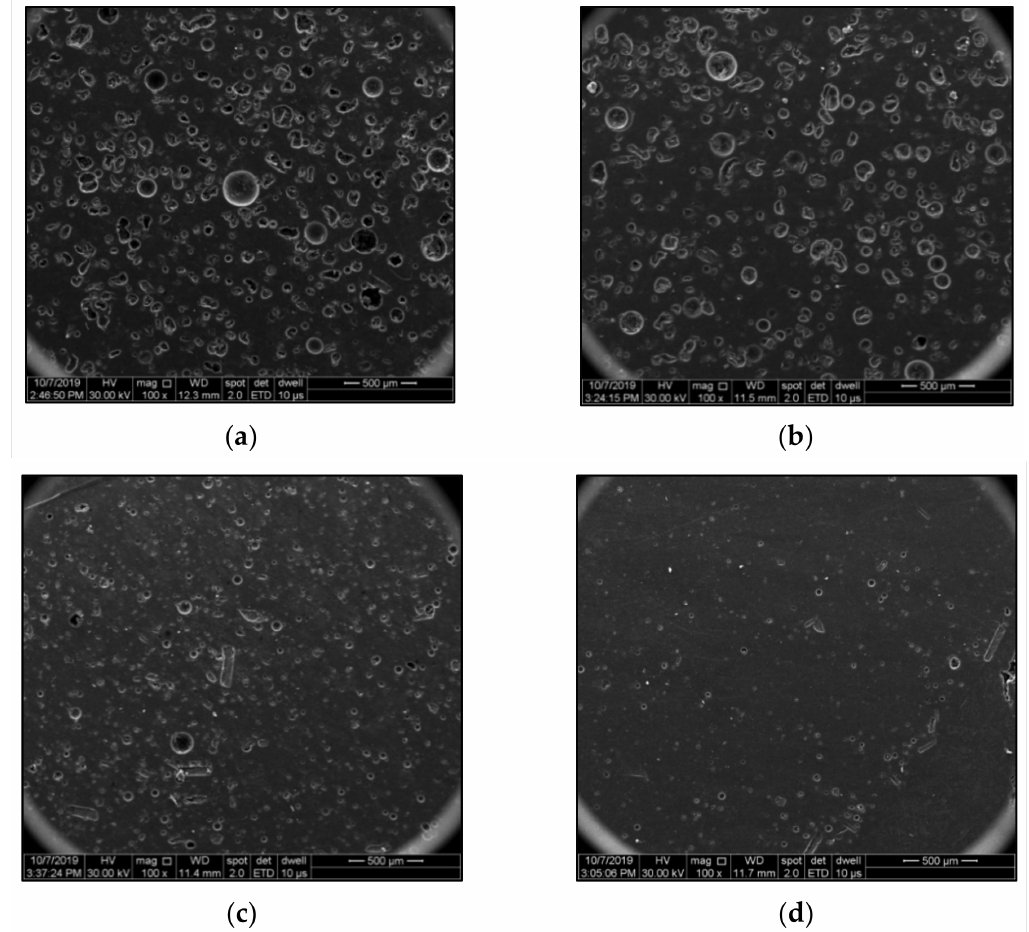
Figure 5. SEM images illustrating the dispersion by ( a ) magnetic stirring and ( b ) sonication for the PUF-DCPD system and dispersion by ( c ) magnetic stirring and ( d ) sonication for the MUF-ENB